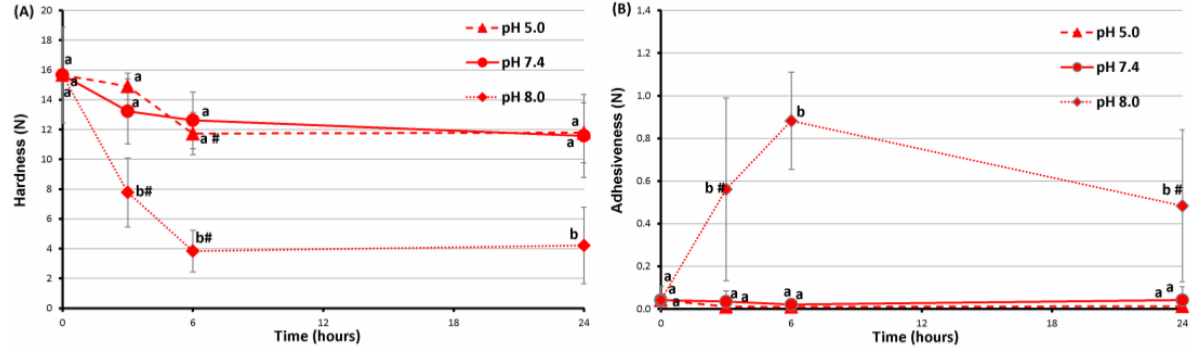
Figure 7. The hardness ( A ) and adhesiveness ( B ) of FeP hydrogel incubated in Hanks ’ solution at a pH of 5.0, 7.4, and 8.0 for 24 h. Different letters — p < 0.05 for different pH conditions; # — p < 0.05 vs. previous time point.